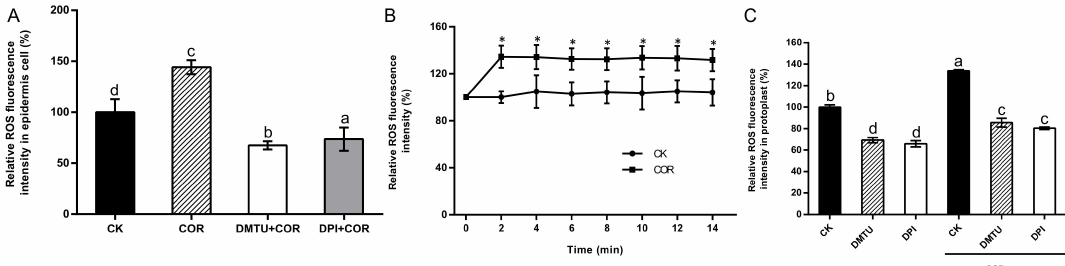
Figure 8. ROS production induced by COR in maize leaves and protoplasts. Effect of COR-induced ROS production in maize epidermal cells ( A ) and protoplasts ( C ) with DMTU and DPI. Values are means ± standard error, and different letters indicate significant differences ( p < 0.05) among the treatments. ( B ) Dynamic accumulation of COR-induced ROS production in maize protoplasts. Data was collected every 2 min from 0 to 14 min. Values are the mean ± SD, asterisks indicate significant differences ( p < 0.05) between CK and COR treatment using student’s t